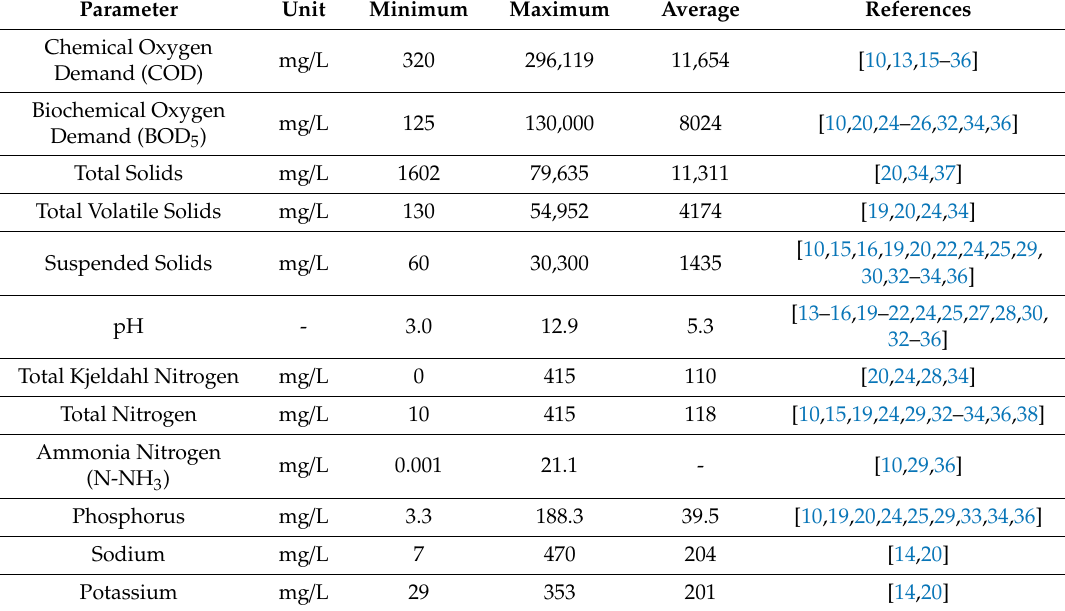
Table 1. Conventional wastewater pollutants in winery wastewater as reported in literature.